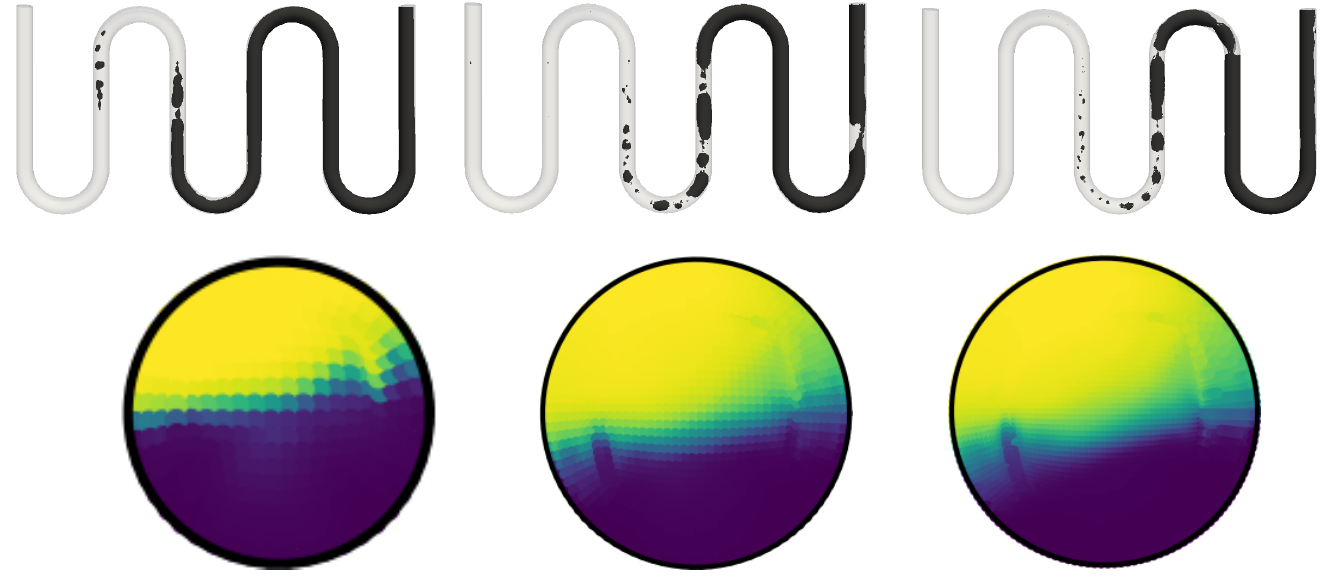
Figure 5. Mesh convergence analysis: D ∆ = 20 ( left ); D ∆ = 40 ( center ); D ∆ = 60 ( right ). ( Top ): regime identification—instantaneous visualization of isocontour α v = 0.5 produced the large interfaces in the domain. ( Bottom ): average fields of void fraction in section